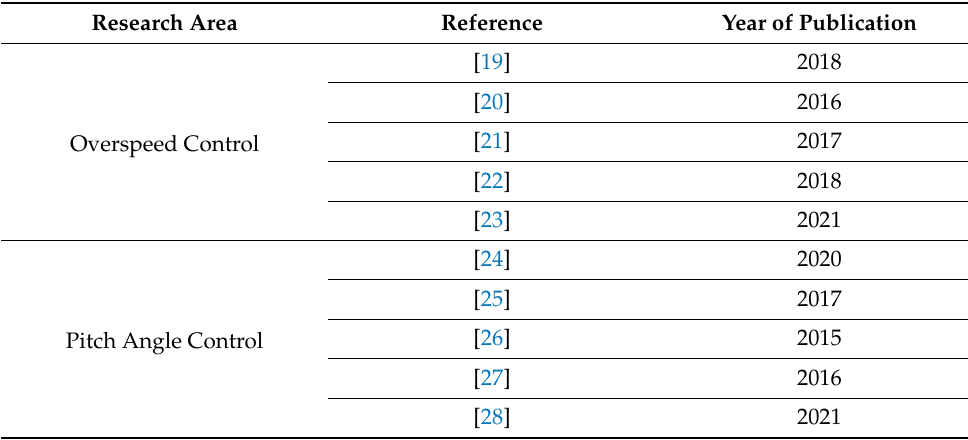
Table 2. Publications in De-loading Control for VSWTs.